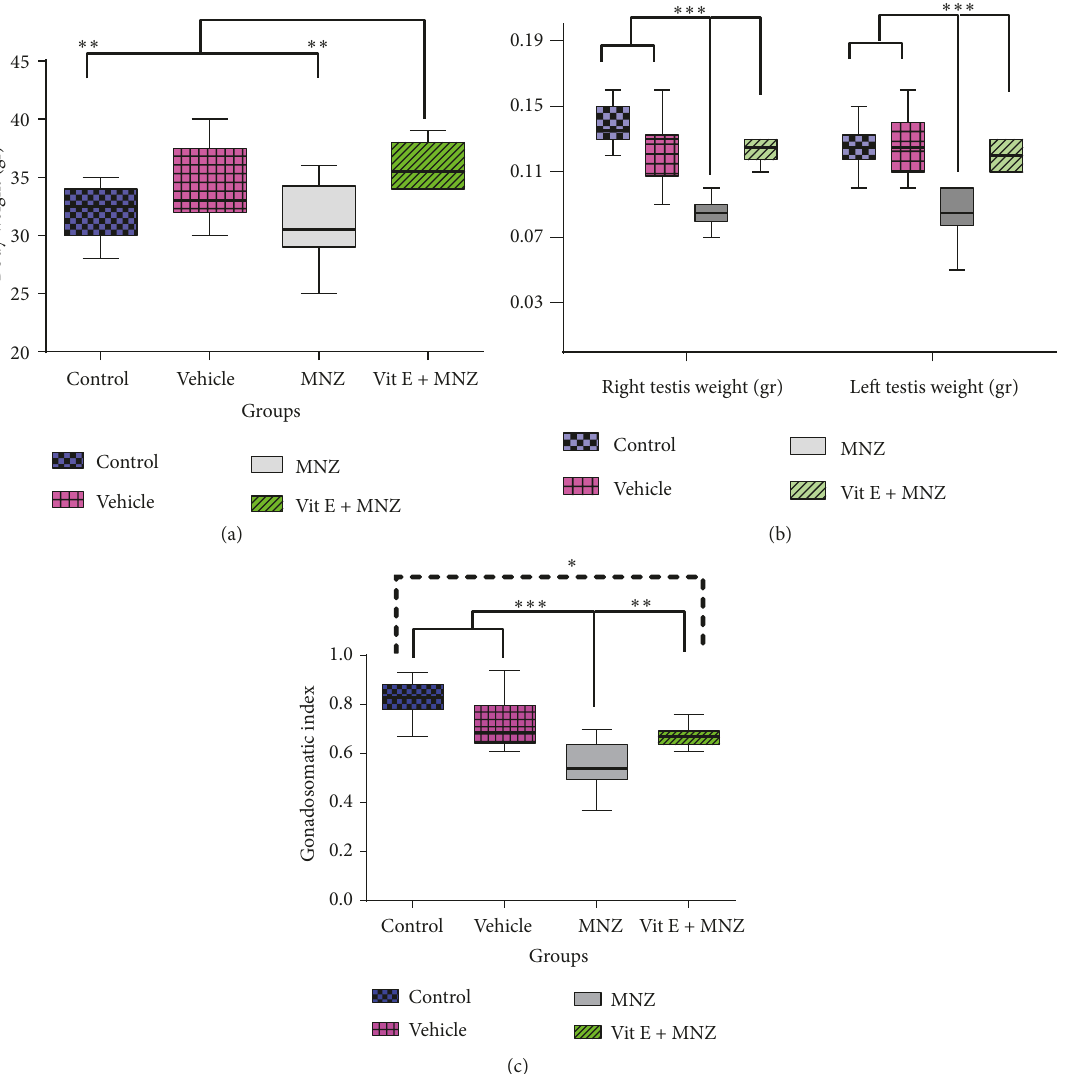
Figure 4: The effect of mancozeb administration alone and with vitamin E during intrauterine life and lactating periods on the weight of body (a) and right and left testis (b) and gonadosomatic index (GSI) (c) in the different groups (n=10). MNZ: mancozeb. ∗ , ∗∗ , and ∗ ∗ ∗ indicate p < 0.05, p < 0.01, and p < 0.001,